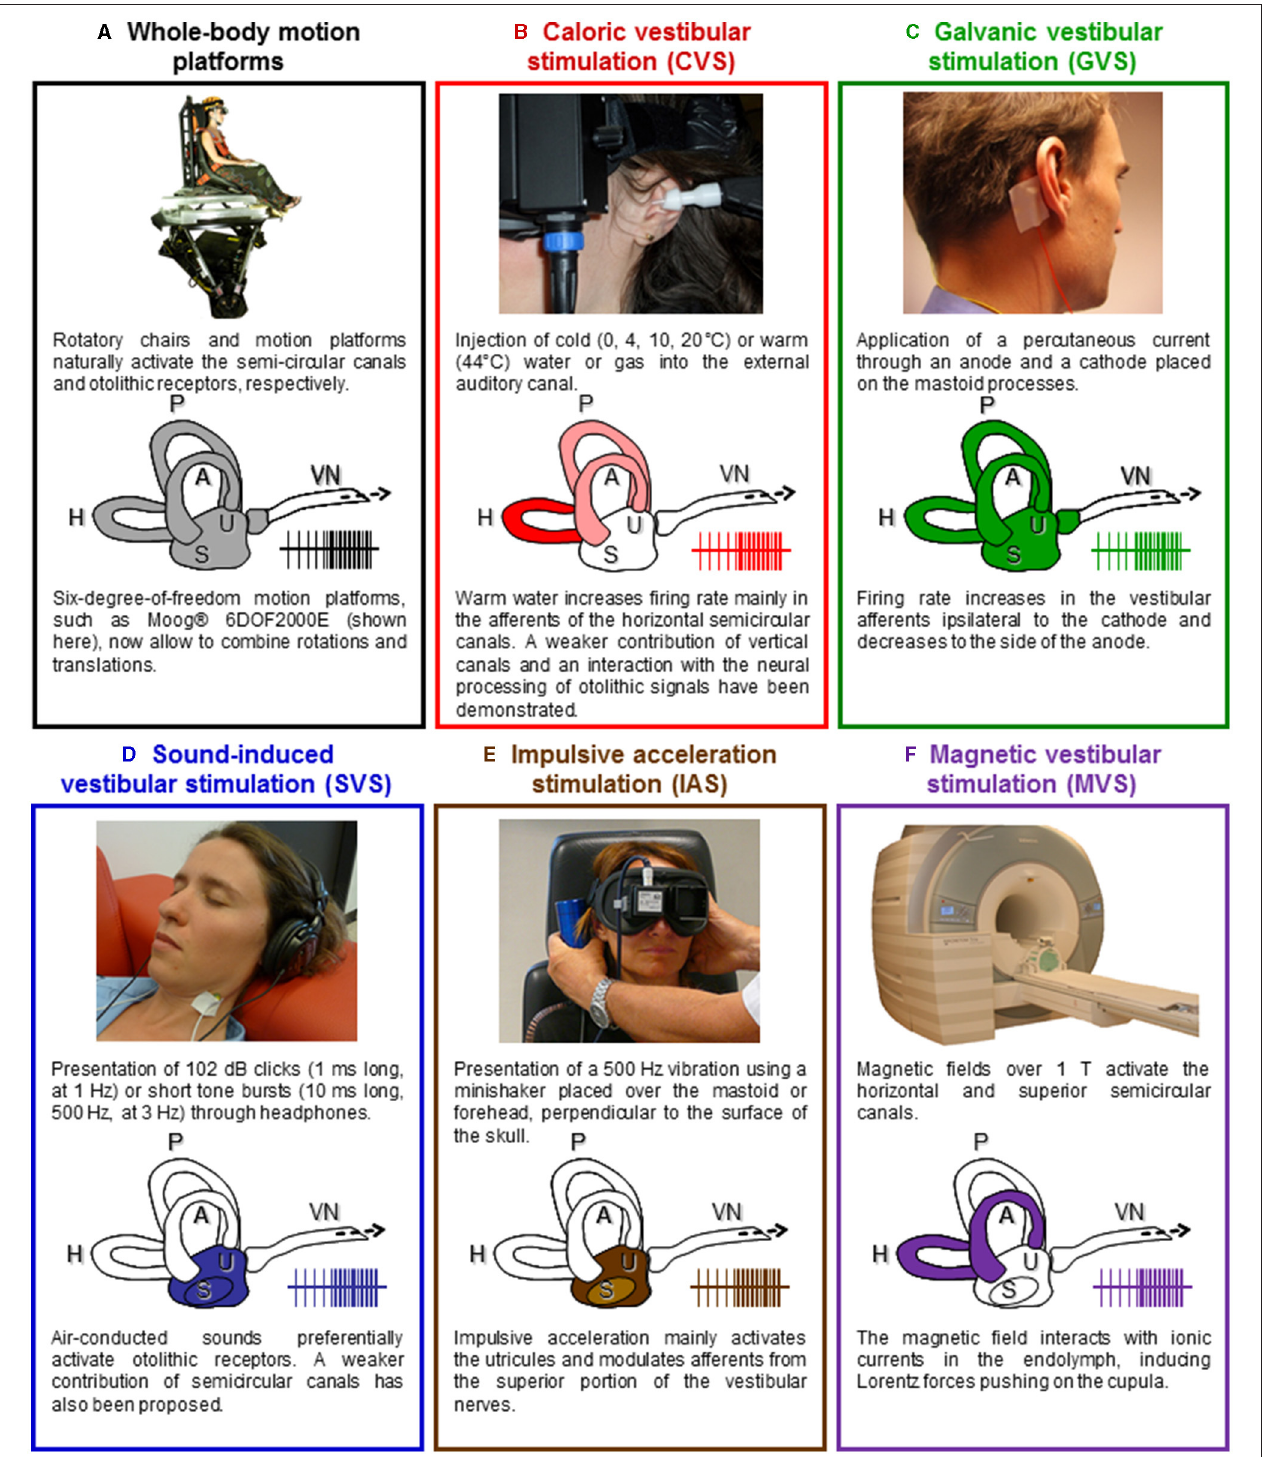
FIGURE 2 | Vestibular stimulation techniques. (A) Rotating chairs stimulate the semicircular canals and linear motion platforms and tilting devices deliver natural stimulation to the otolithic receptors (the utricule and the saccule). New motion platforms with precise control of the amplitude, acceleration, and velocity of passively applied movements now allow to study responses to complex natural vestibular stimulation. Illustration adapted with permissions from (62). (B) Caloric vestibular stimulation (CVS) consists of irrigating the external auditory canal with warm or cold water or airflow. Caloric vestibular stimulation evokes a nystagmus and self-motion perception, often leading to vertigo and a sensation of dizziness. Illustration adapted from (15) with permissions from Elsevier. (C) Galvanic vestibular stimulation (GVS)